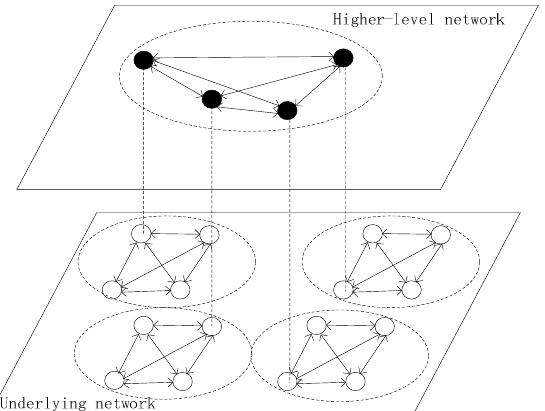
Figure 2. Multi-agent PBFT model for a blockchain system.